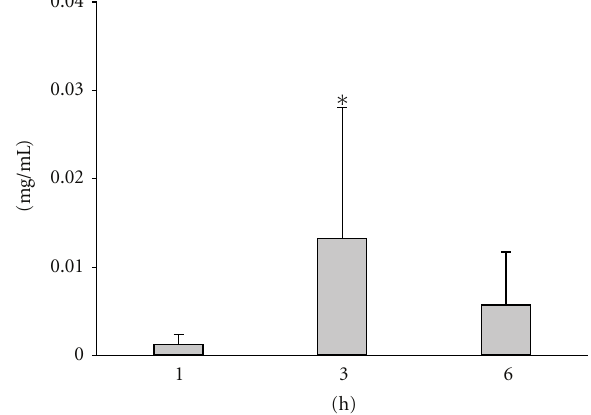
Figure 5: The absorption of ibuprofen. The bars display mean values ± SD. The values are given in mg/mL. ∗ P < 0 . 05 versus 1h